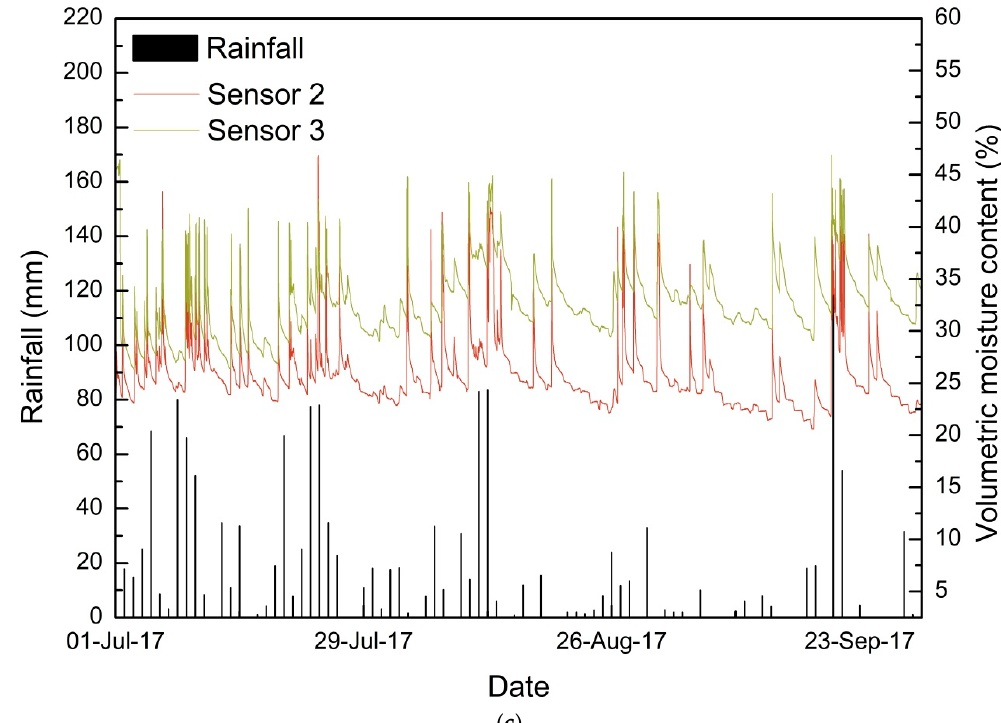
Figure 8. Detailed time history for monsoon 2017 of sensors 2 and 3: ( a ) tilting angle in the direction parallel to the slope, ( b ) tilting angle in a direction perpendicular to the slope, and ( c ) volumetric moisture content.